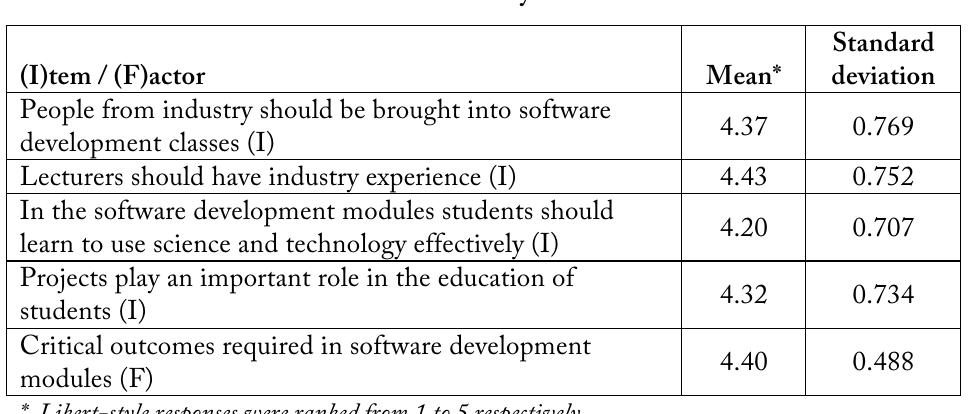
Table 7: Basic analysis of